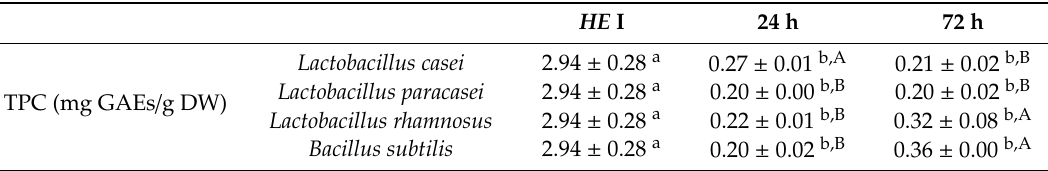
Table 1. Total phenolic content (TPC) of H. elongata extracts obtained after fermentation.